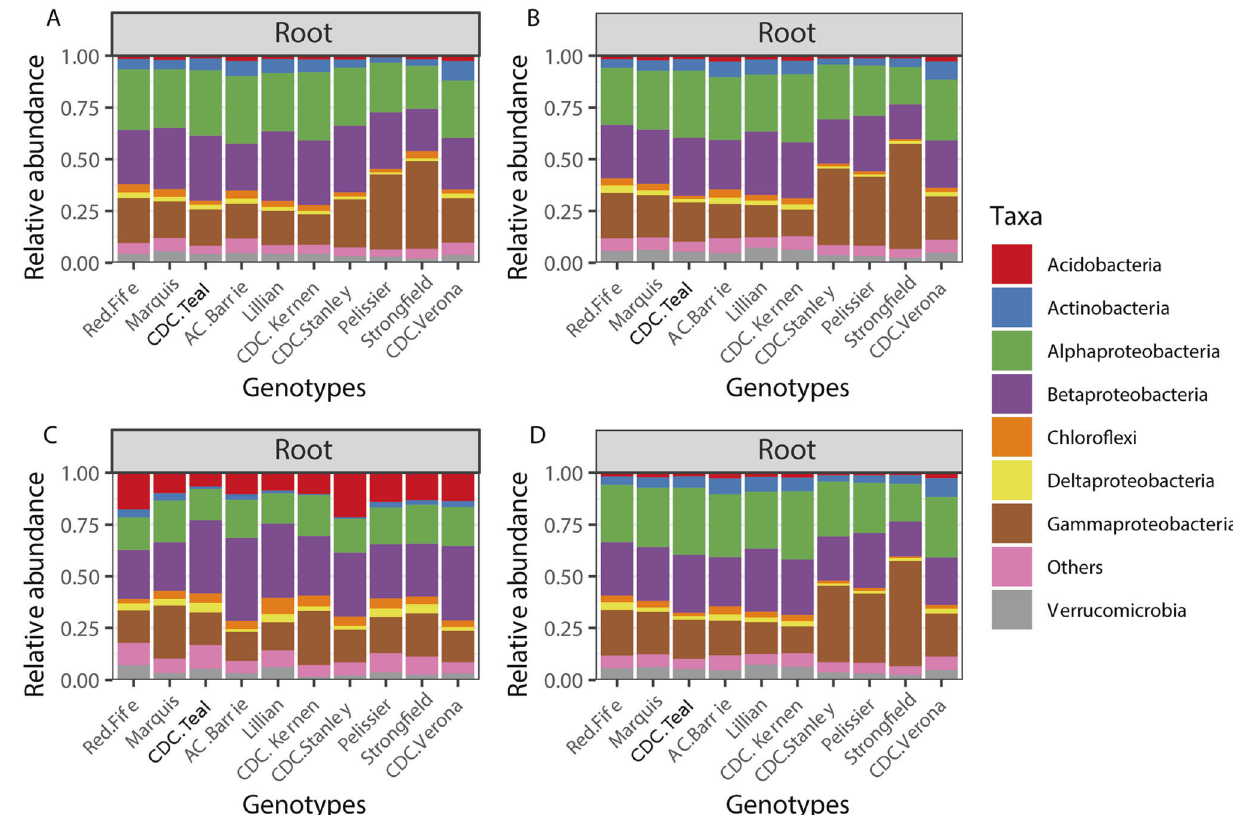
Fig. 4 Community composition of the most abundant phylum/class based on the cpn60 gene amplicons for the growth stage/ compartment combinations that showed a signi fi cant ( P < 0.10) effect of genotypes in Table 3. ( A ) 2013, roots, stem elongation; ( B ) 2013, roots, dough development; ( C ) 2014, roots, dough development, ( D ) 2016, roots, dough